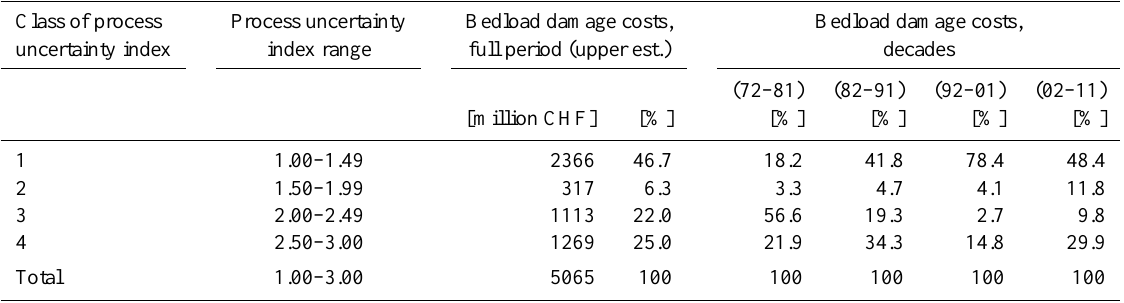
Table 4. Bedload damage costs associated with a certain range of the process uncertainty